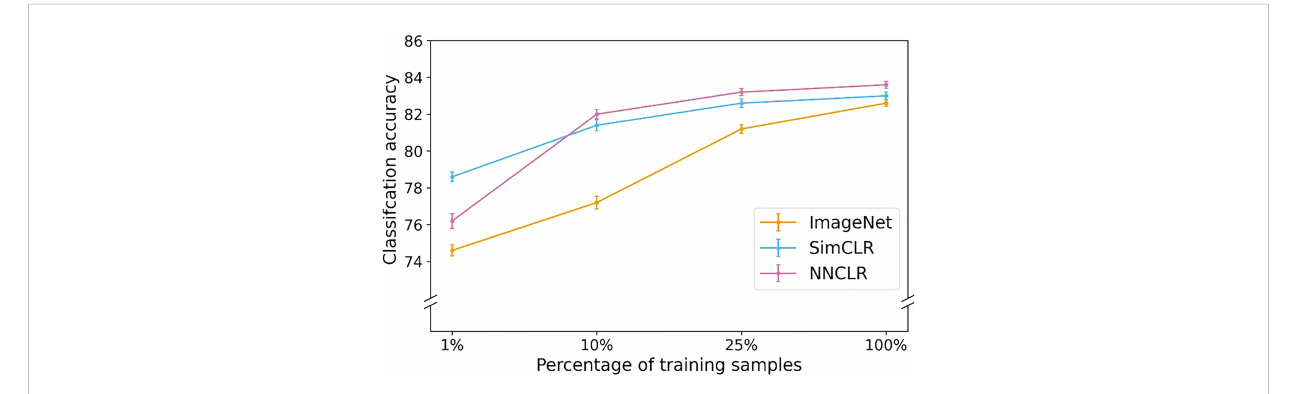
FIGURE 6 Feature extraction classi fi cation accuracy versus percentage of training samples for three types of weight